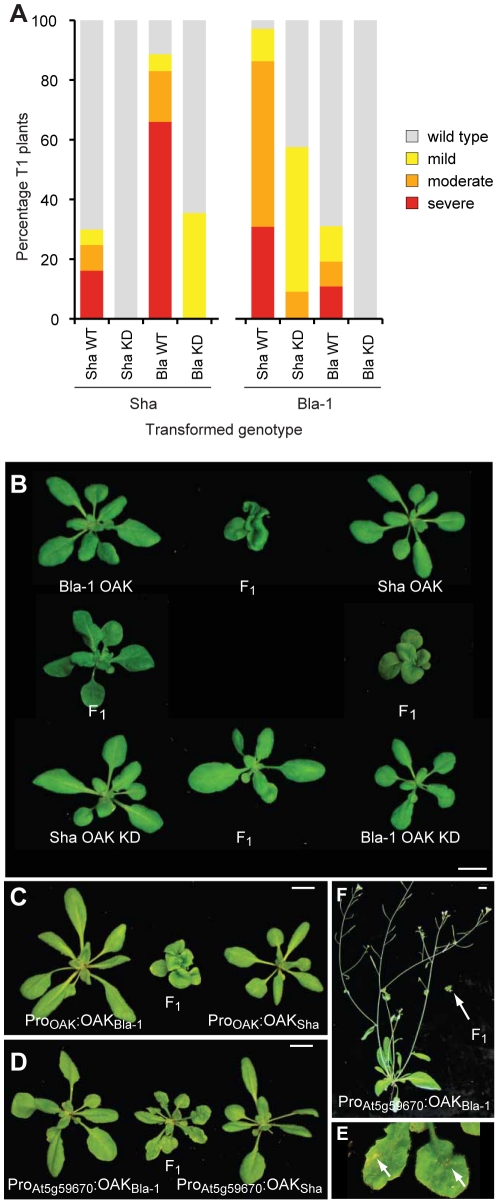
Requirement of OAK kinase activity and expression domain for hybrid phenotype.(a) Phenotypic distribution of T1 plants (n≥90) expressing kinase dead (KD) or wild-type (WT) versions of OAK. (b) Crosses of Col-0 plants carrying Bla-1/Sha POAK∶OAK KD constructs. Representative F1 plants from crosses among five pairs of independent, phenotypically normal T1 plants are shown with alongside the parental lines. Scale bar = 1 cm. (c) Crosses of five pairs of phenotypically normal Col-0 plants transformed with POAK∶OAKSha and POAK∶OAKBla-1, or (d, e) with PAt5g59670∶OAKSha and PAt5g59670∶OAKBla-1. Plants in (b-d) are 4-weeks old, in (e) 6-weeks old. Arrows in (f) indicate regions of cell death visible to the naked eye on a close-up of the F1 plant in (d).